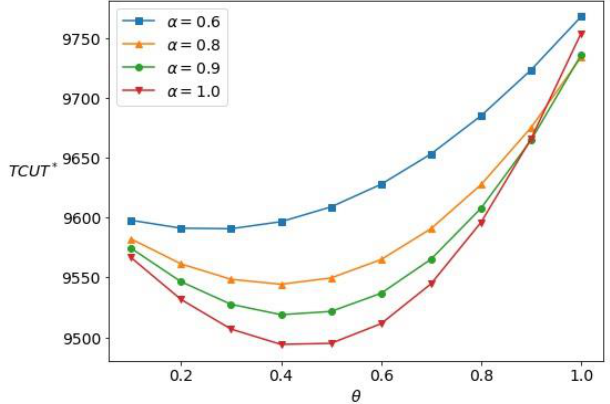
Fig. 5. Change of TCUT with respect to θ for various